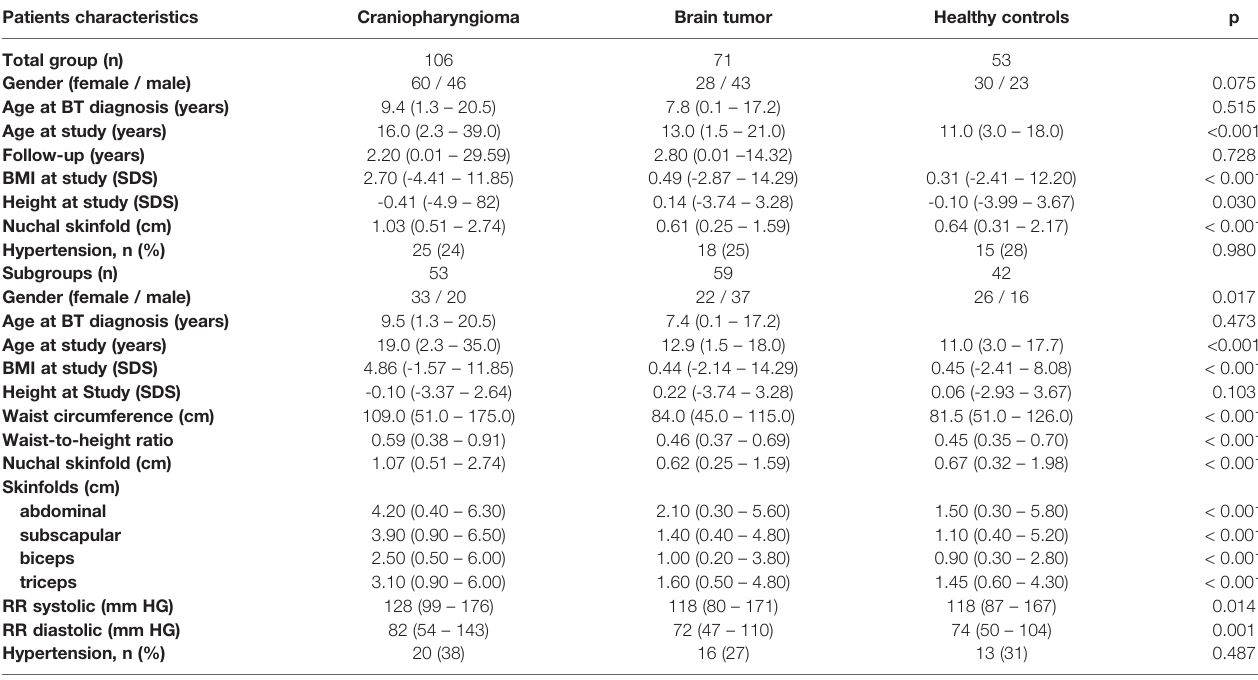
TABLE 1 | Characteristics of the groups of patients (106 childhood-onset craniopharyngioma, 71 childhood brain tumor patients) and 53 healthy controls and the subgroups of patients (53 craniopharyngioma, 59 brain tumor patients) and 42 healthy controls, who could be analyzed for further parameters (waist circumference, waist-to-height ratio, caliper-measured skinfold thickness) and blood pressure (systolic and